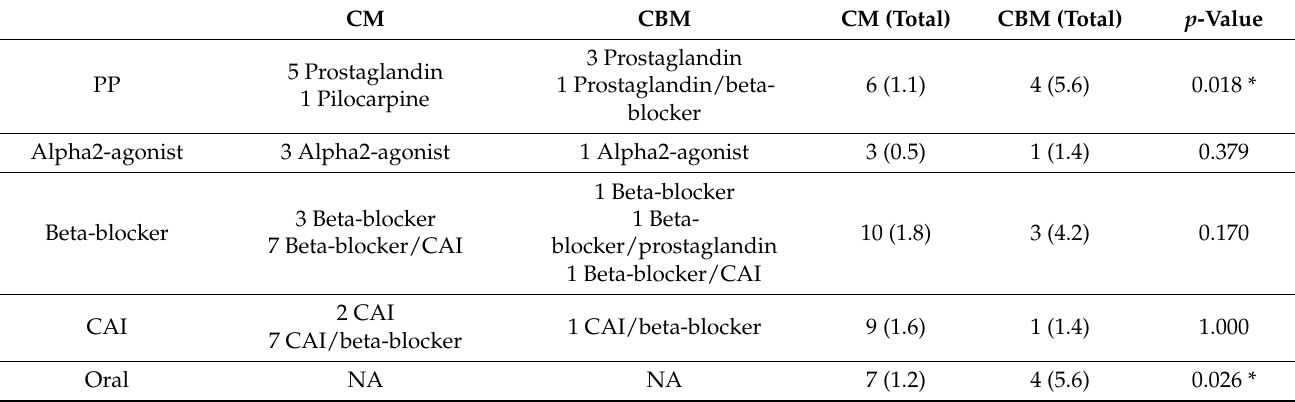
Table 1. IOP-lowering medication use between choroidal- and ciliary body